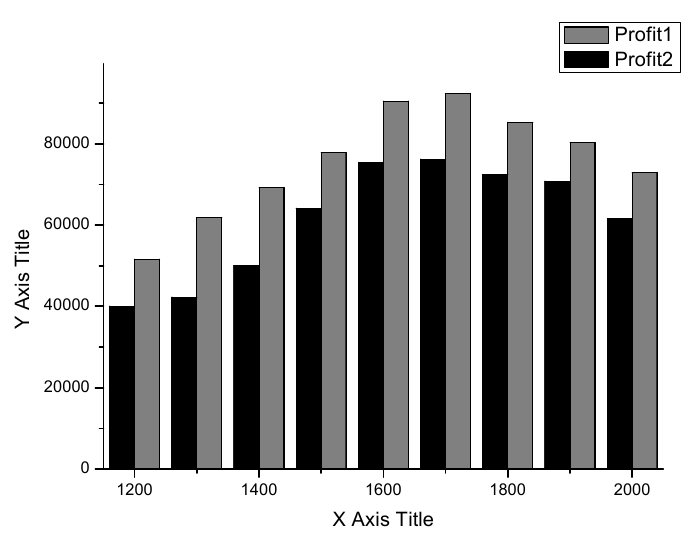
Figure 4. Profit graph of DG1